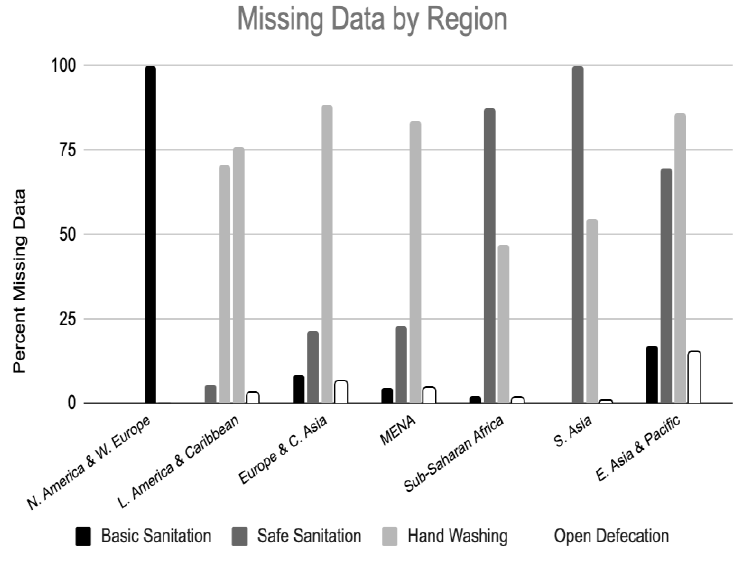
Figure 2. Missing Data